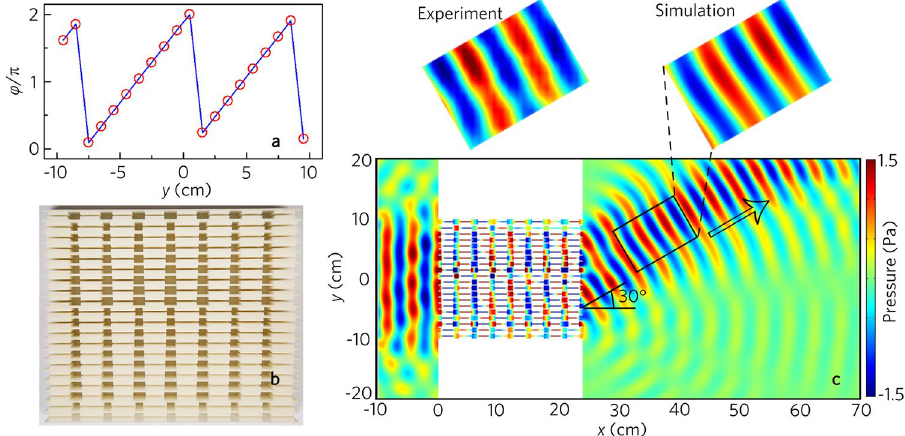
Figure 7. Acoustic negative refraction with a beam. ( a ) Distribution of twenty acoustic metafibers along y direction as indicated by their discrete phase shift (twenty red hollow dots) resembling the desired phase profile ϕ ( y ) (blue line). ( b ) Photograph of the designed metafiber bundle. ( c ) Simulated and measured acoustic pressure field distributions with the acoustic metafiber bundle illuminated by the normally incident plane wave at 8.0 kHz. Black arrow in ( c ) refers to the theoretical value of the